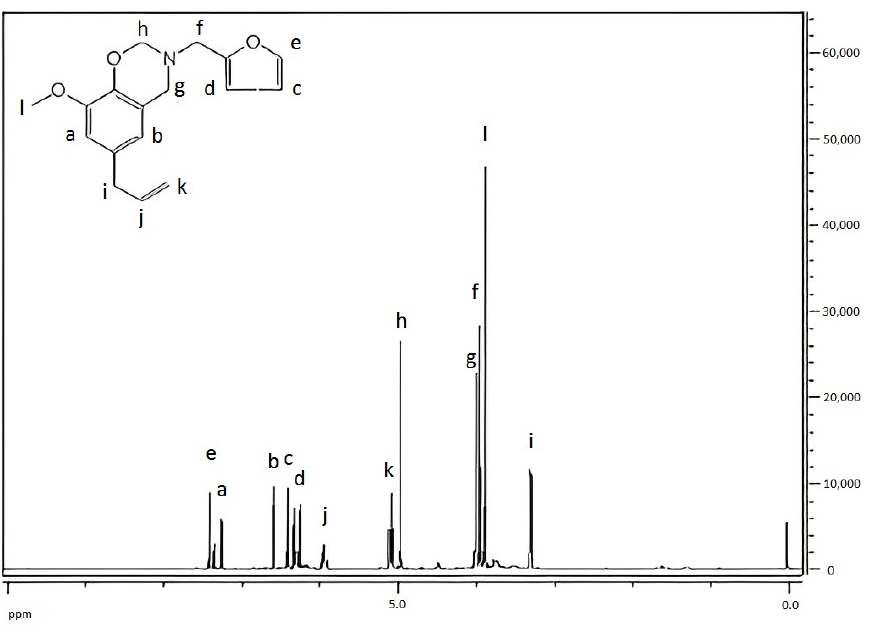
Figure 8. 1 H ‐ NMR spectrum of benzoxazine (eugenol) .